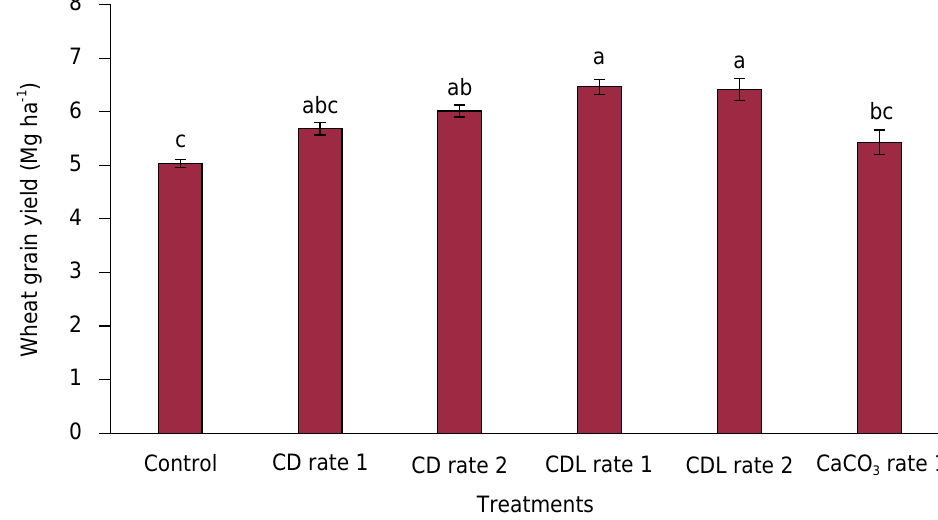
Figure 2. Wheat grain yield at Temuco in response to six treatments of soil acidity control. Different letters over the bars indicate differences between treatments according to Tukey’s test (p<0.05). Lines over the bars indicate standard error. AD: boiler ash + dregs; ADS: boiler ash + dregs + lime sludge; Rate 1: CaCO 3 reference rate; Rate 2: 2 × rate